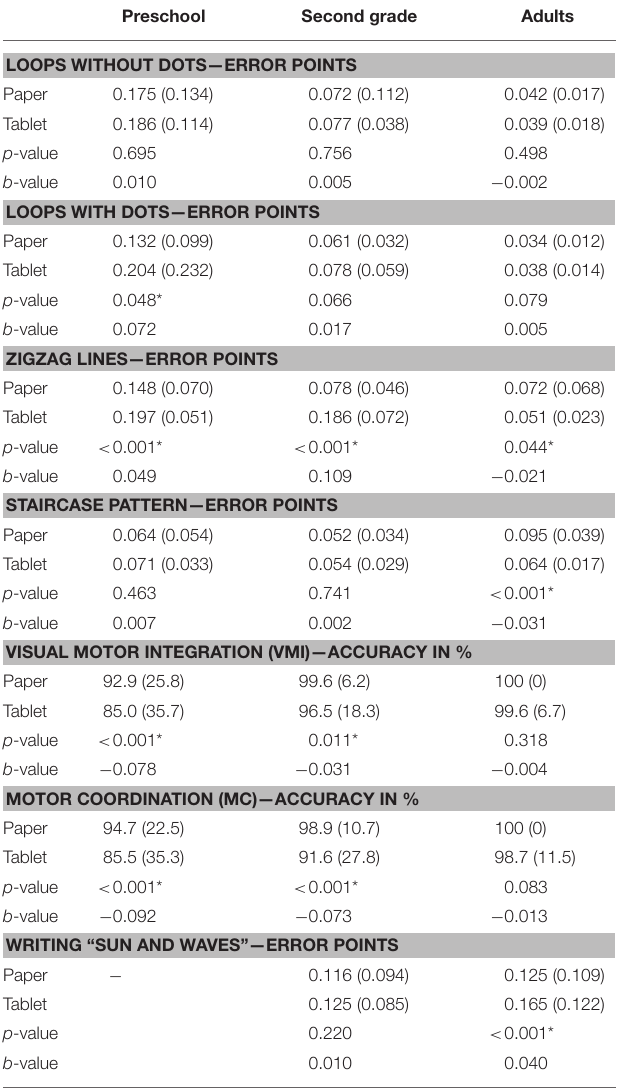
TABLE 1 | Means and standard deviations in parentheses for the scoring of the handwriting